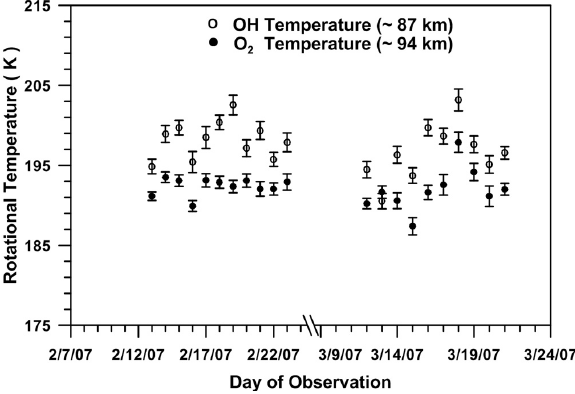
Fig. 1. Nocturnal mean values of OH and O 2 temperatures at Kol- hapur during February–March